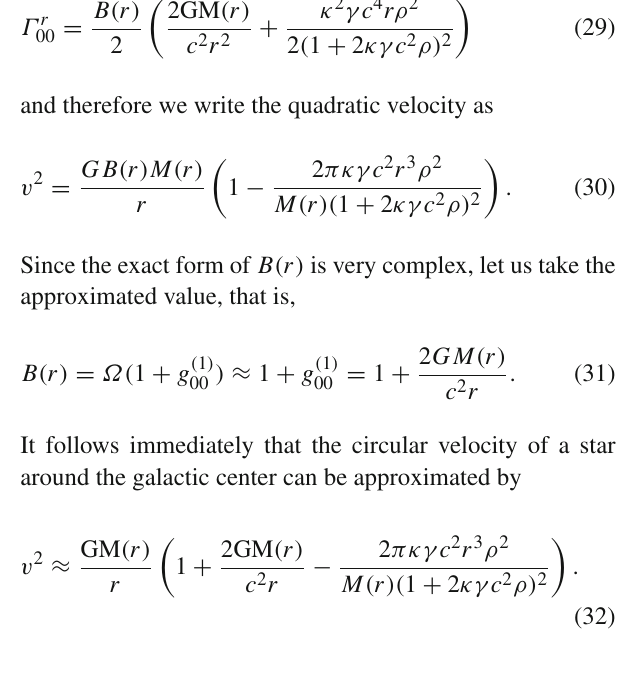
Table1 Best-fitresultsaccordingtoEq.(32)usingtheparametricmass distribution (28). These numerical values correspond to rotation curves presented in Fig. 2. Col. (1) galaxy name; Col. (2) total gas mass, in units of 10 10 M (cid:7) , given by M gas = 4 / 3 M HI , with the M HI data taken from [61]; Col. (3) measured scale length of the galaxy in kpc; Col. (4) galaxy luminosity in the B-band, in units of 10 10 L (cid:7) , calculated from [61]; Col. (5) presents the best-fit results for the predicted total mass of thegalaxy M 0 (in10 10 M (cid:7) units);col.(6)givesthepredictedcoreradius r c inkpc; Col.(7) reduced χ 2 r ;and Col.(8) thestellarmass-to-light ratio in units of M (cid:7) / L (cid:7) . Note: all six galaxies are of type HSB